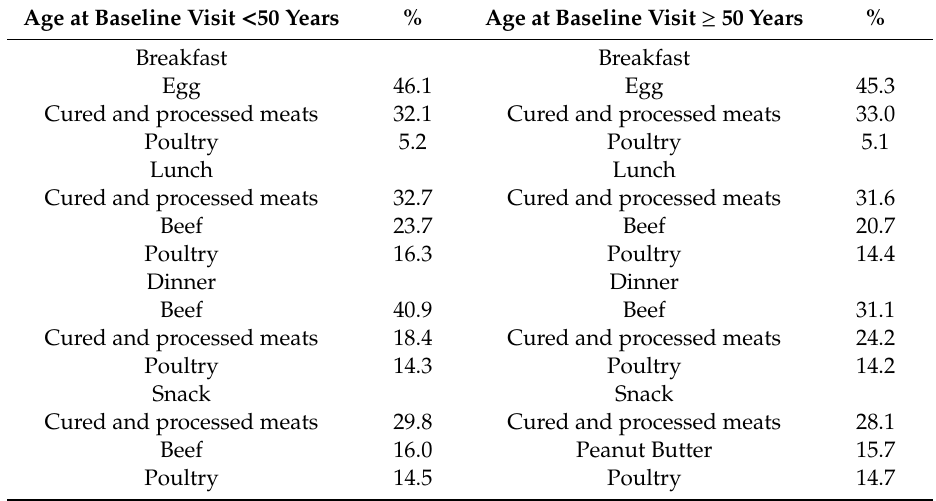
Table 3. Top three types of sandwiches consumed by eating occasion by age of HANDLS study participants ( n = 1213) a .